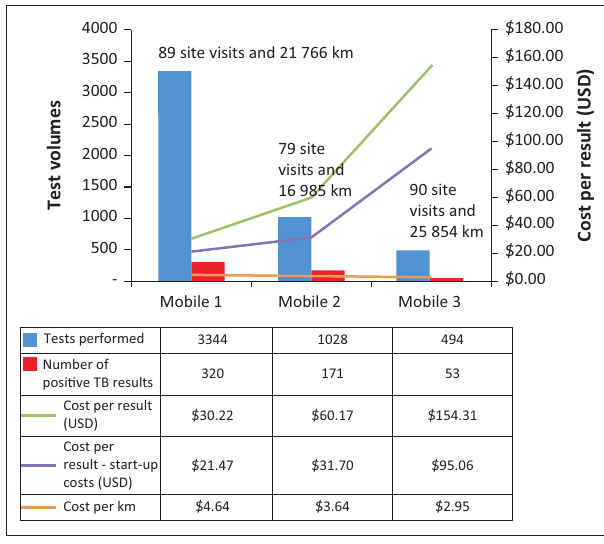
FIGURE 1: Number of tuberculosis tests performed (dark blue bars) by mobile Xpert MTB/RIF testing units in high-burden peri-mining communities in South Africa, 2018. Positive results (red bars) are reported on the primary y -axis. On the secondary y -axis, the green line indicates the total cost per result in USD, the purple line indicates the total cost per result less start-up costs, and the orange line indicates the cost per kilometre travelled. The number of site visits for testing and the total distance travelled for those visits are indicated as text for each mobile